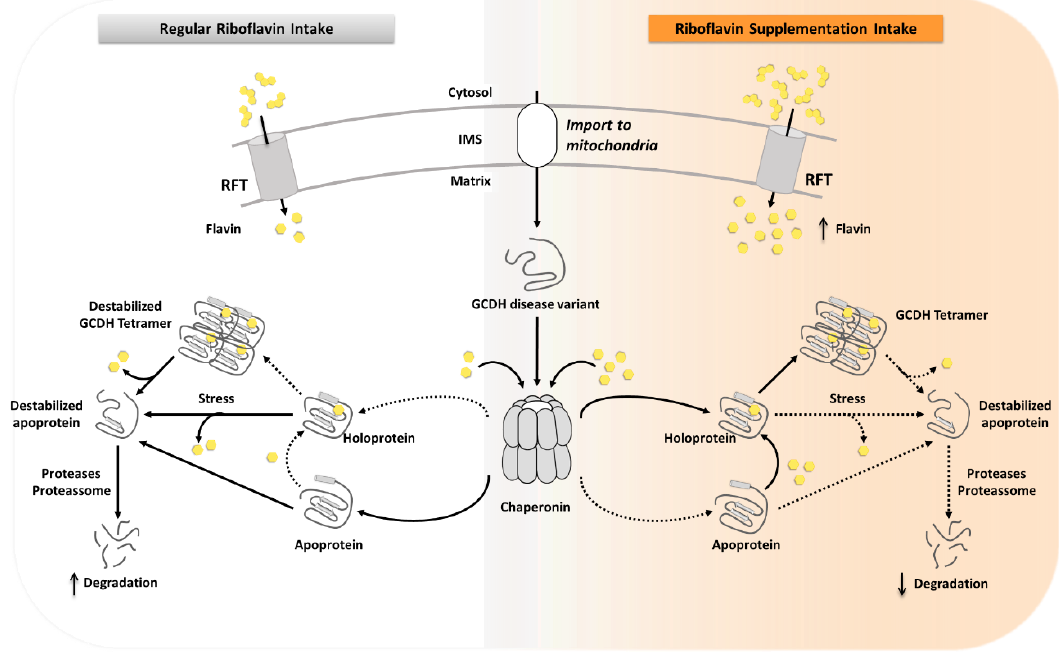
Figure 7. Scheme depicting the impact of FAD availability in GCDH disease variants during regular riboflavin intake versus riboflavin supplementation. After import into the mitochondria, the unfolded GCDH protein might enter the chaperonin to acquire its proper fold, as observed for other acyl-coenzyme A (CoA) dehydrogenases (ACDHs). Subsequently, the protein can follow two pathways: either the folded monomer is released from the chaperonin as an apoprotein or flavin (yellow solid hexagon) can be incorporated into the folded GCDH monomer being released as holoprotein. If the GCDH disease variant has a mutation that impairs cofactor binding, it will reduce the formation of holoprotein. Apoprotein will be conformationally unstable and targeted for degradation. In contrast, the holoprotein will assemble into a tetrameric functional structure; however, due to the disease-causing mutation, it will be prone to FAD loss and degradation. This situation will be critical under pathophysiological situations, such as fever, which will accelerate release of the incorporated FAD and increase susceptibility for degradation. Under riboflavin supplementation, flavin levels are increased in the mitochondrial matrix, resulting in an increase of GCDH holoprotein, which assembles into functional tetramers. In an environment with high FAD concentration, loss of cofactor even under stress condition is decreased, lessening the chances of degradation and improving GCDH functional capacity.